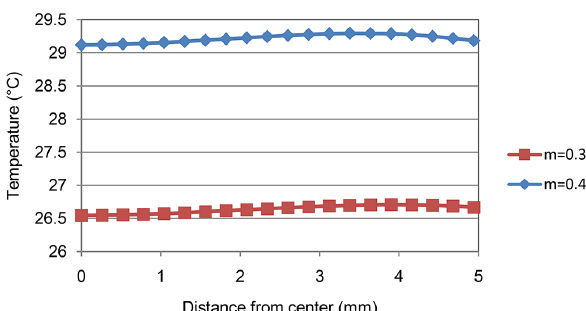
Fig.9: Temperature distribution in radial direction for HPT processed work-piece as a function of friction at the end of the